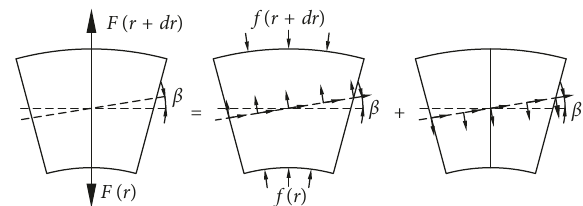
Figure 5: Influence of the anchor on the cohesive force of the surrounding rock reinforcement body: (a) the wedge-shaped unit of the anchor and surrounding rock; (b) anchor vertical action; (c) anchor lateral